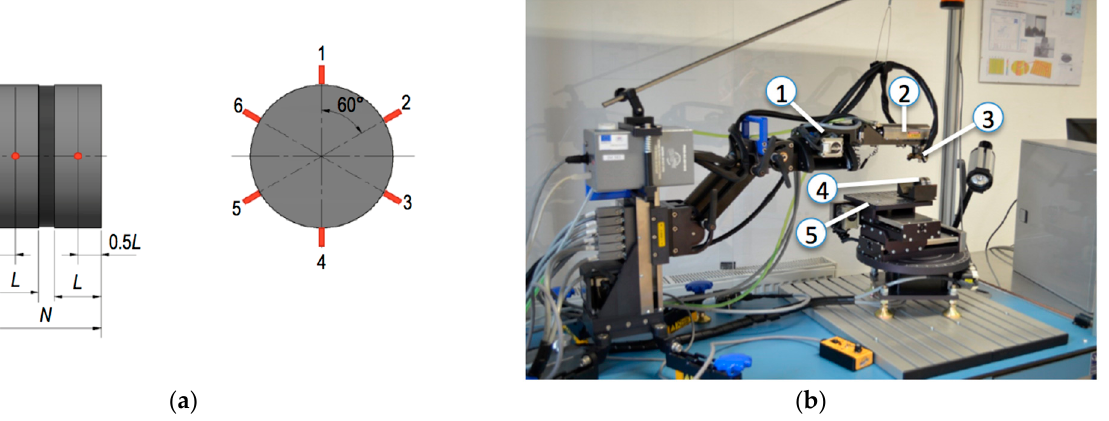
Figure 5. Measurement of the residual stress: ( a ) positions of the measuring points; ( b ) diffractometer Proto iXRD: 1—measuring arm, 2—X-ray lamp, 3—two detectors capturing the diffraction cone, 4—examined sample, 5—adjustable and rotating table.